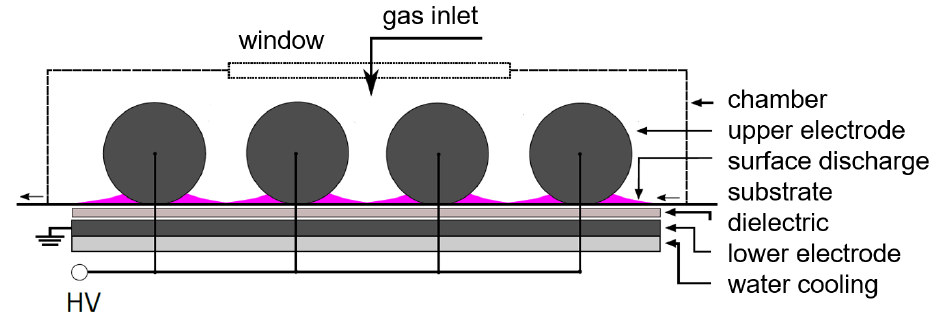
Figure 4. The scheme of deposition